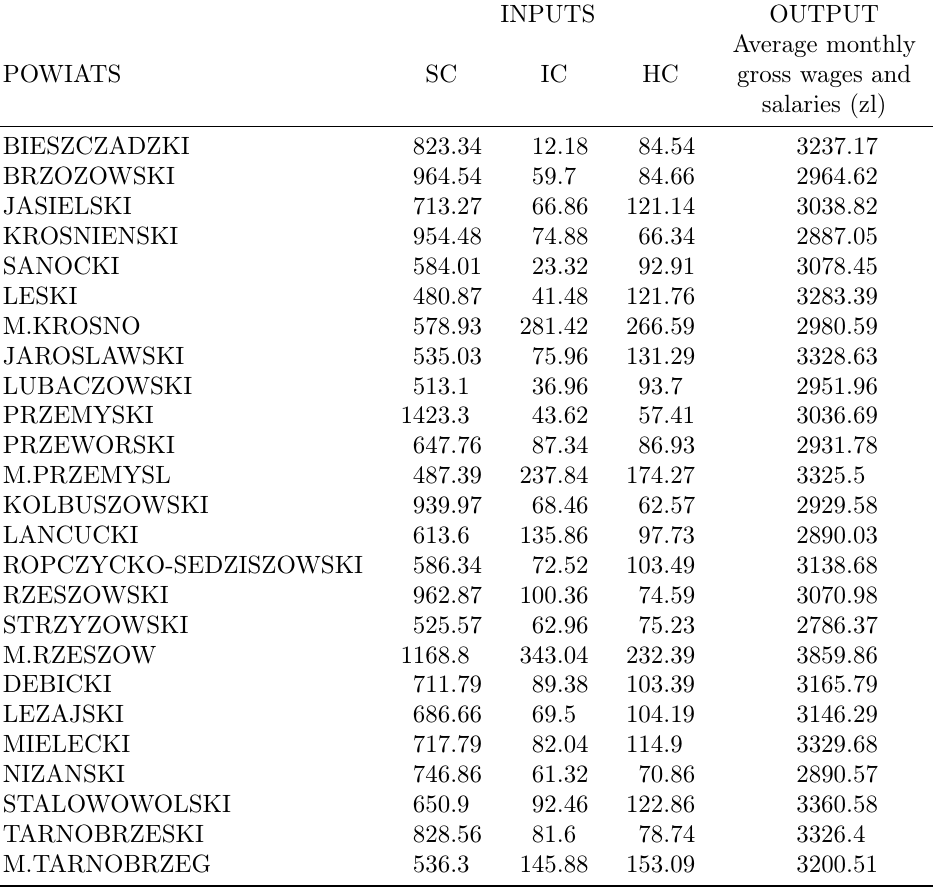
Table 2: The multivariate database (reduced into a single-period database with 3 inde- pendent factors by means of a FPCA) for the 25 powiats in the Podkarpackie region